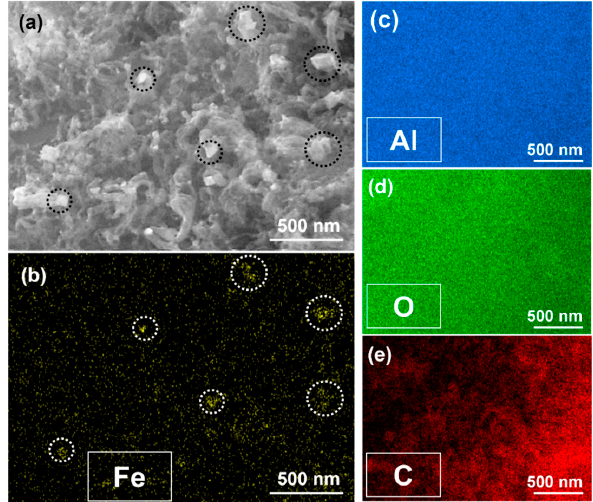
Figure 7. ( a ) SEM and corresponding EDS mapping images for ( b ) iron, ( c ) aluminum, ( d ) oxygen, and ( e ) carbon, respectively. The CNT was grown on Al 2 O 3 at 650 °C for 10 min with 10 rpm of RCVD chamber. Black circles in ( a ) correspond to white circles in ( b ) indicating Fe particles.